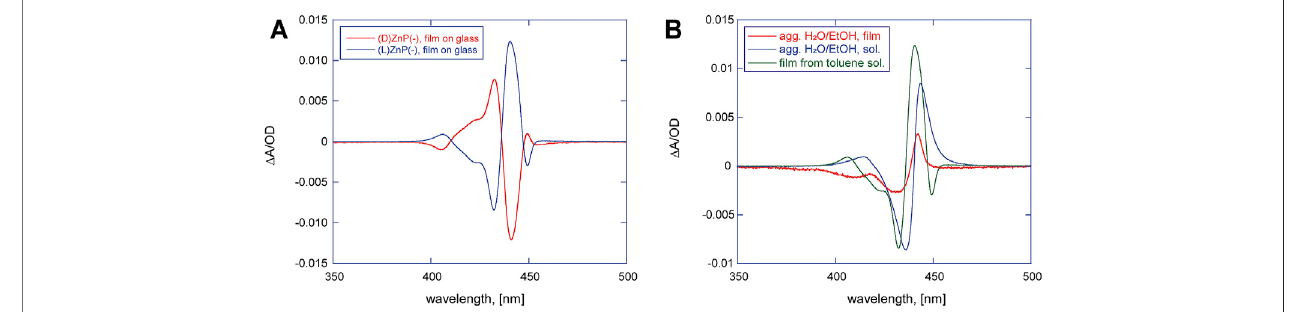
FIGURE 1 | (A) Circular dichroism (CD) spectra of (D)- (red trace) and (L)ZnP(-) (blue trace) casted fi lms on glass from 10 − 4 M toluene solutions. (B) (L)ZnP(-) chiral aggregates obtained in different conditions: aggregates grown from EtOH/H 2 O (25:75, v/v) at 5 μ M concentration (blue trace) and the corresponding fi lm on glass (red trace); chiral fi lms on glass from 10 − 4 M toluene solution (green